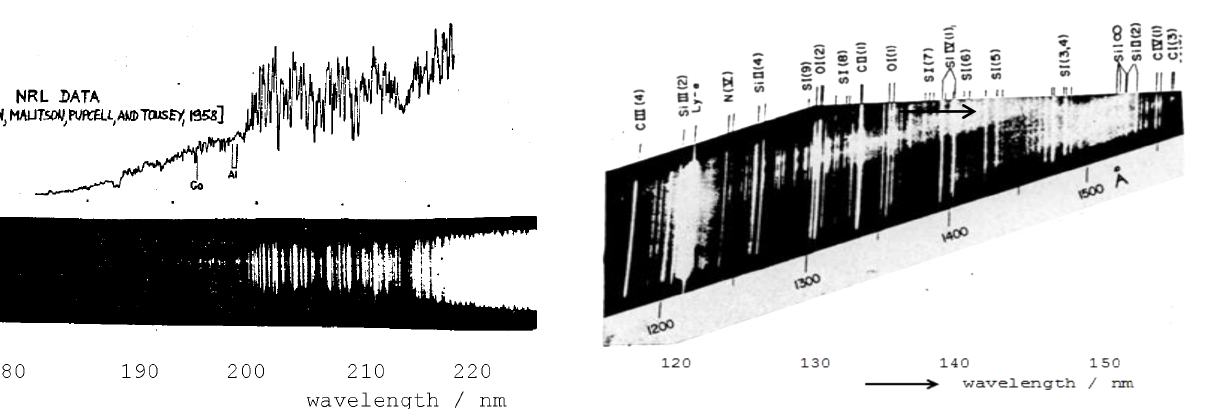
Figure 3. Solar emissions from the photosphere and the transi- tion to the lower chromosphere (Johnson et al., 1958; ©AAS, re- produced with permission): densitometric record (upper part) and photographic spectrogram (lower part).